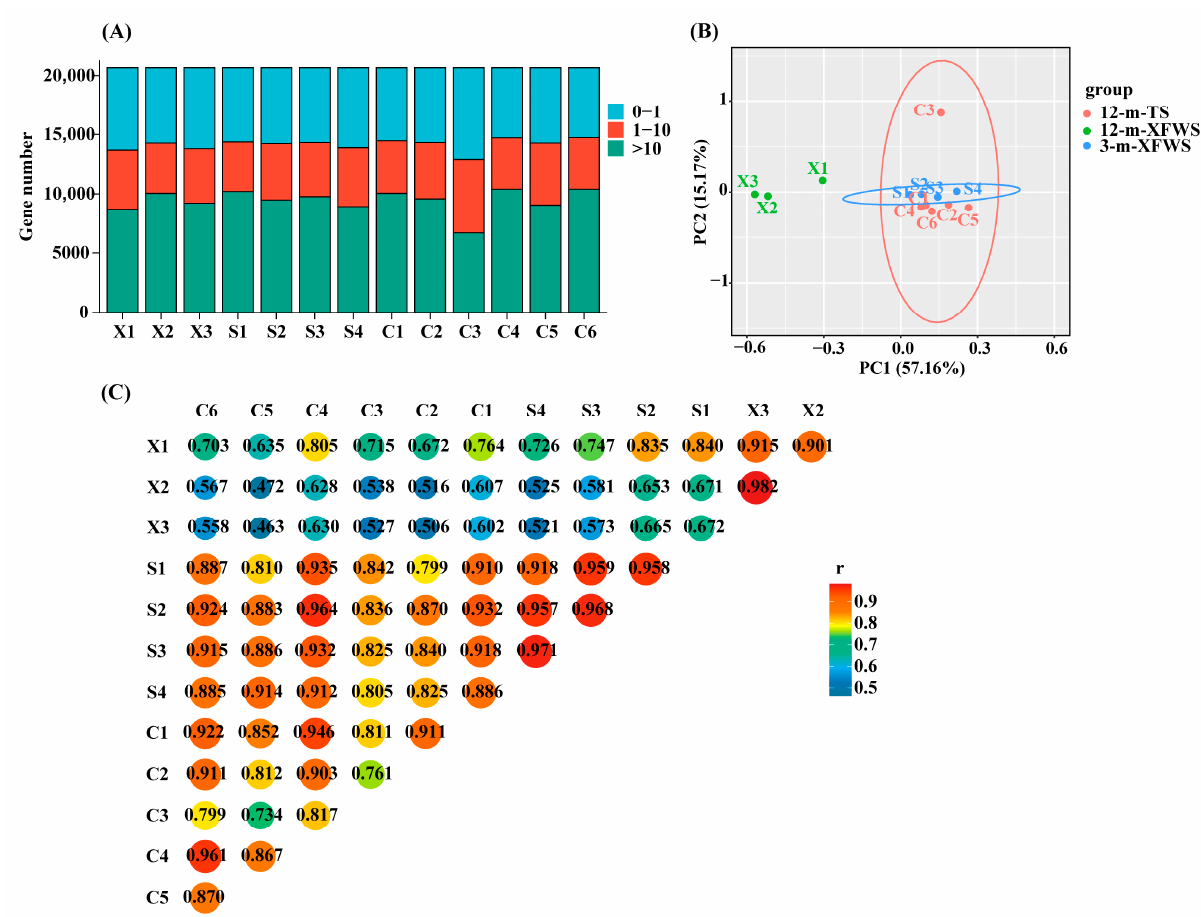
Figure 1. Sequencing quality analysis. ( A ) Statistical analysis of TPM from the 13 RNA sequencing libraries (TPM, the transcripts per kilobase of exon model per million reads mapped value). ( B ) PCA plot of the 13 RNA-Seq libraries (PCA, the principal component analysis; 12-m-TS, 12-month-old Tan sheep, n = 6; 12-m-XFWS, 12-month-old Xinji fine-wool sheep, n = 3; 3-m-XFWS, 3-month-old Xinji fine-wool sheep, n = 4). ( C ) Pearson correlation of the 13 RNA sequencing samples.